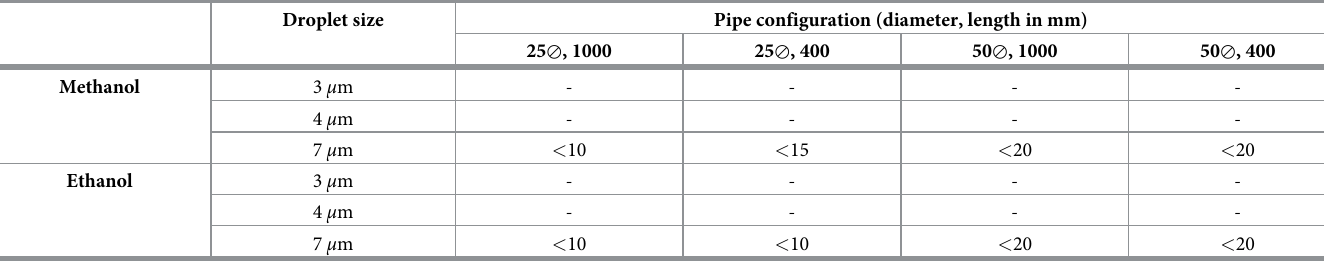
Table 5. t droplet in seconds as a function of droplet size and pipe type (‘-’ stands for “not observed”). Droplet size